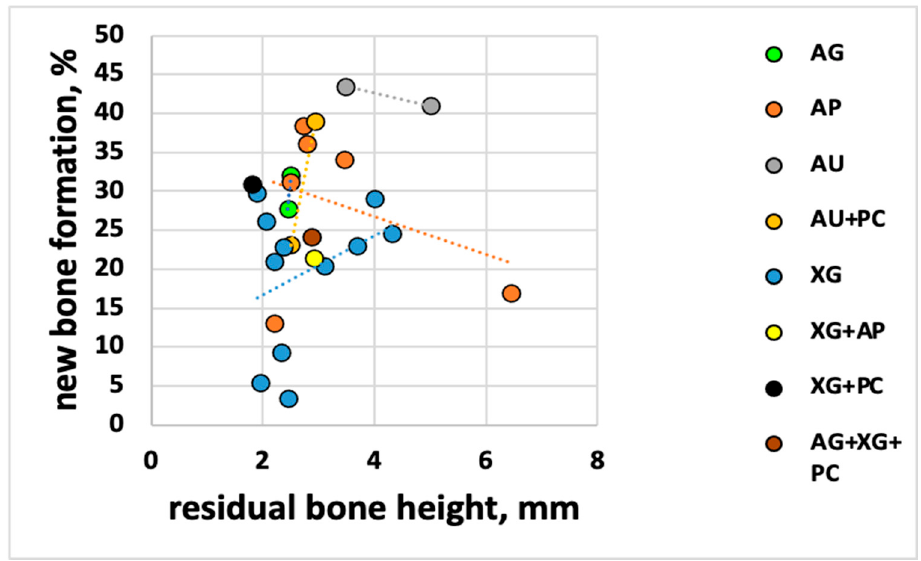
Figure 4. RBH and NBF for each biomaterial. In the second analysis, the NBF% was correlated with the postoperative height (RBH + vertical graft dimension) with the hypothesis that the higher the graft, the lower the new bone formation inside the graft. The overall linear regression analysis showed a tendency in agreement with the hypothesis (Figure 5) with a regression coefficient of R 2 = 0.33 and a slope of − 1.56 (95% CI: − 2.50 to − 0.61), meaning that NBF significantly decreased when postoperative vertical graft dimension increased. Per each mm of vertical height, NBF changed by about 1.6%. The trend was highly significant ( p = 0.0023).